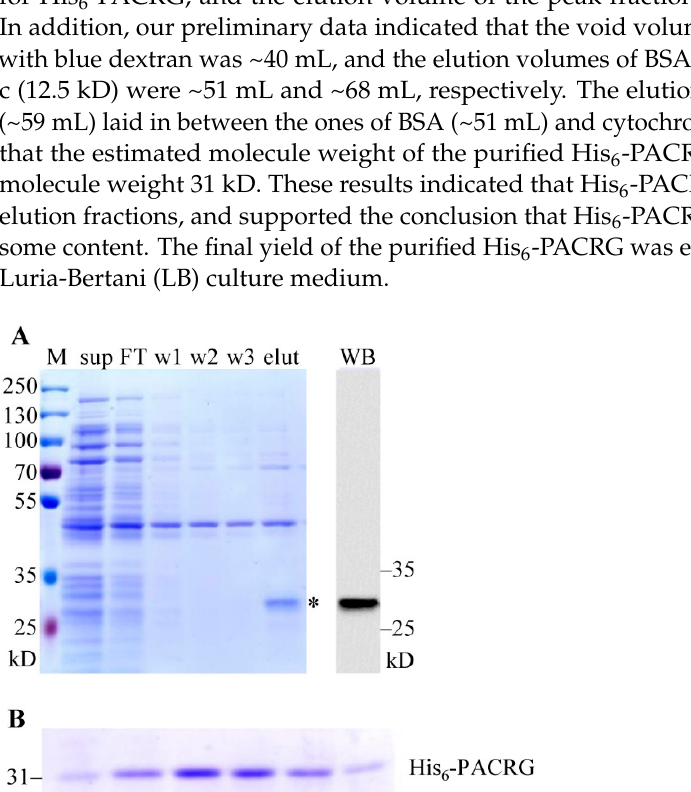
Figure 3. Purifications of His 6 -PACRG and His 6 -GST-PACRG. ( A ) Purification of pCold-PACRG expression product. Left panel: SDS-PAGE analysis and CBB staining of Ni 2+ chelating purification fractions. Sup, supernatant; FT, flow through; w 1–3, fractions washed with sonication buffer, 2 mM and 5 mM imidazole, respectively; elut, fraction eluted with 50 mM imidazole. Right panel: WB analysis of the eluted fraction with PACRG Ab. * denotes His 6 -PACRG. ( B ) Purification of